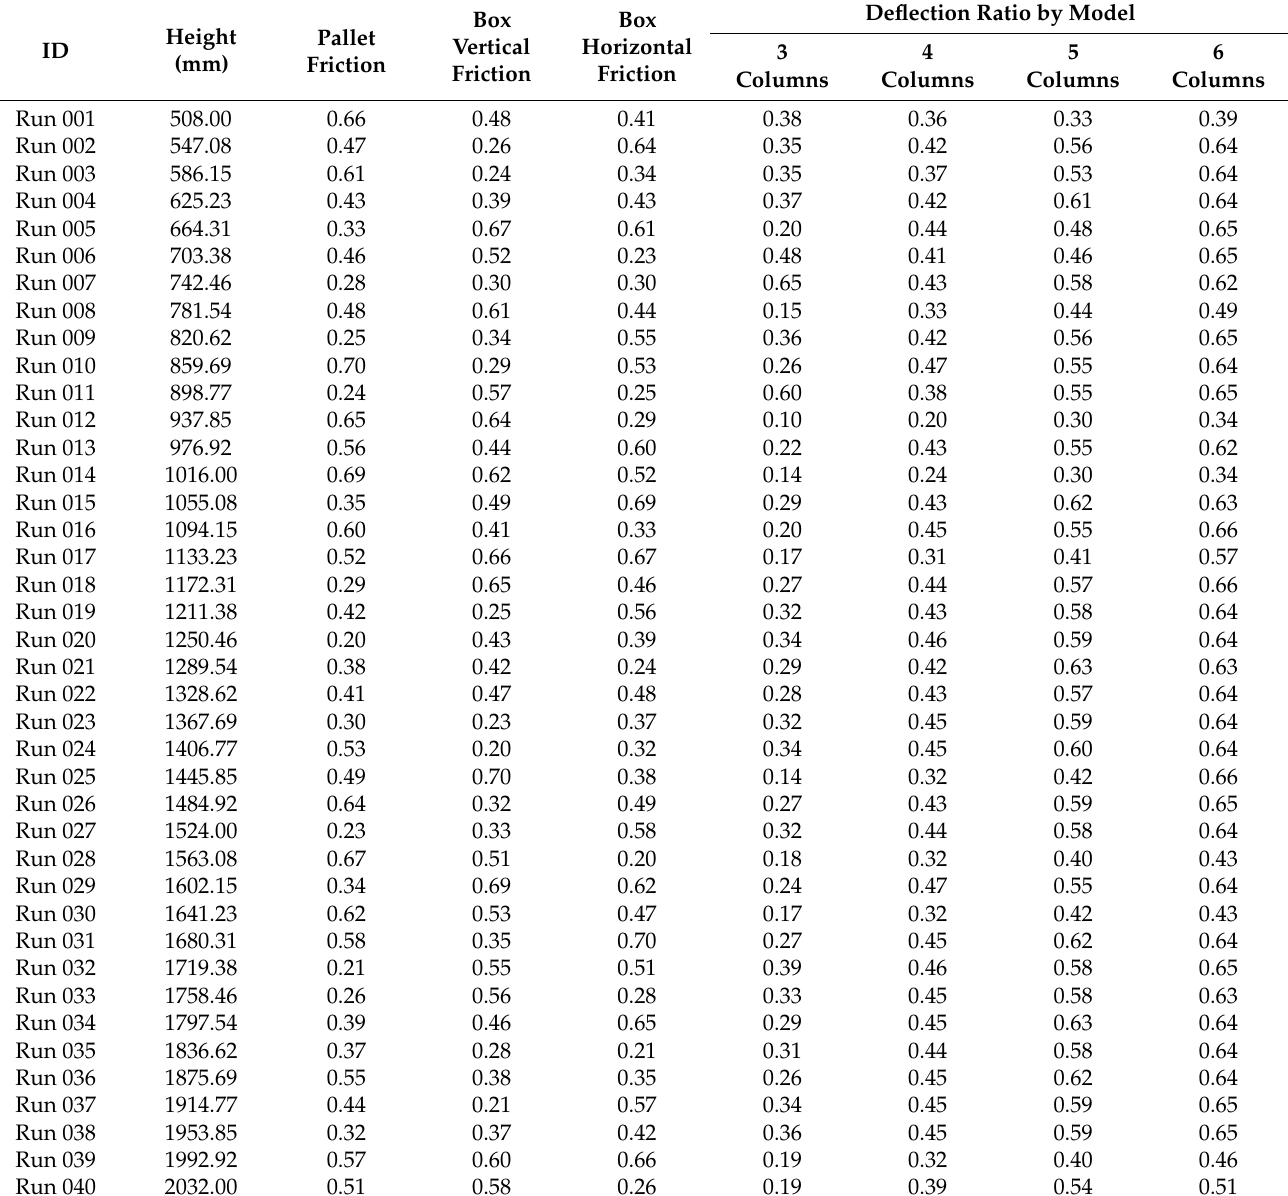
Table 2. Latin Hypercube Design factor levels for Gaussian process model training data and corresponding finite element model simulation results as a ratio of deflection per unit load model.